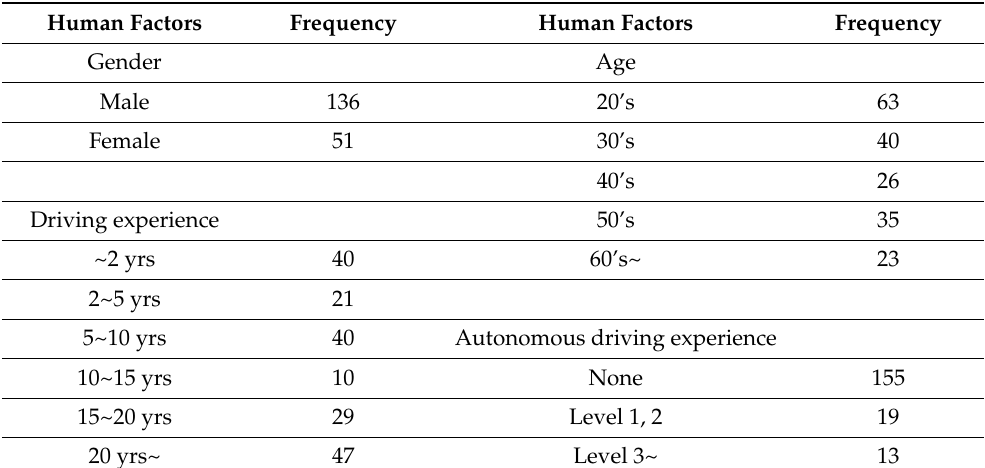
Table 4. Questionnaire investigating the demographic aspects of